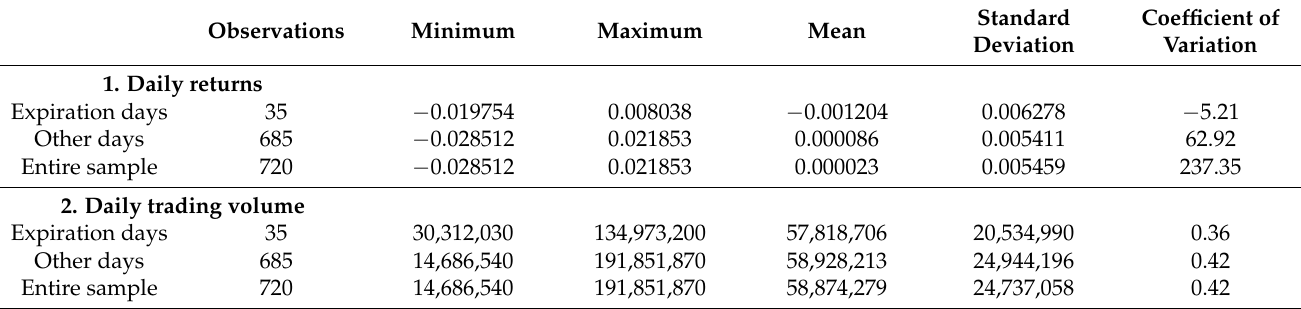
Table 2. Daily returns and summary statistics of the